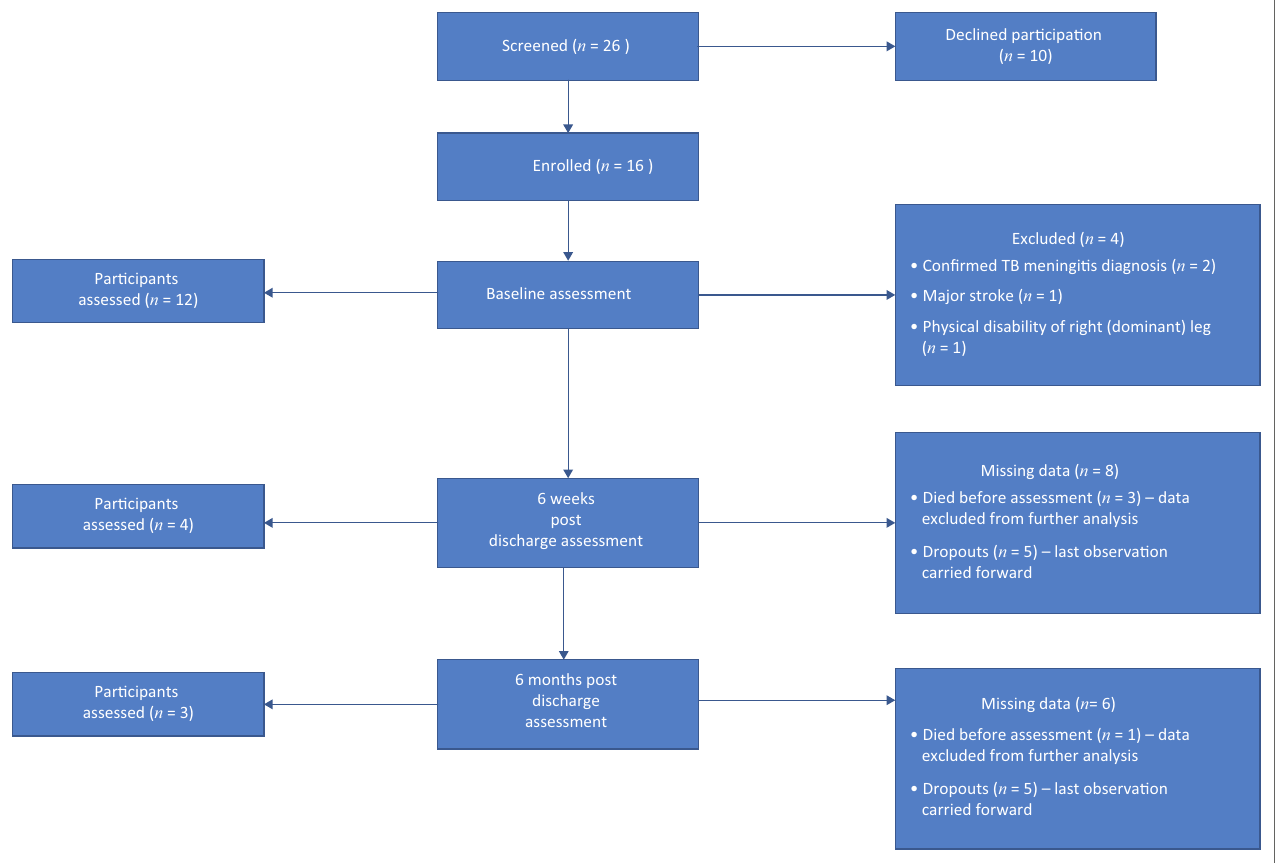
FIGURE 3: Participants recruitment and flow throughout the study